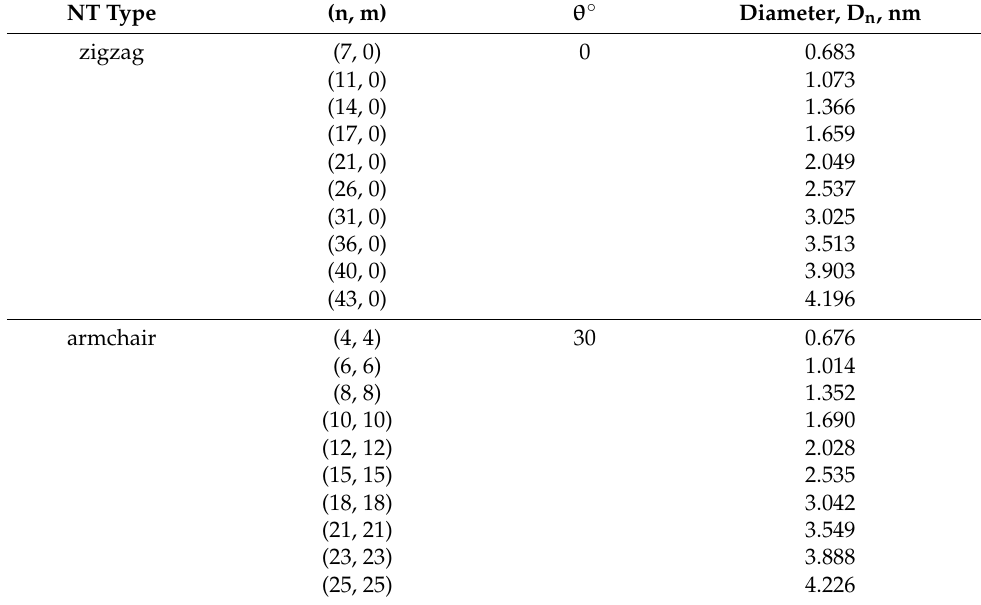
Table 2. Geometrical characteristics of the studied non-chiral